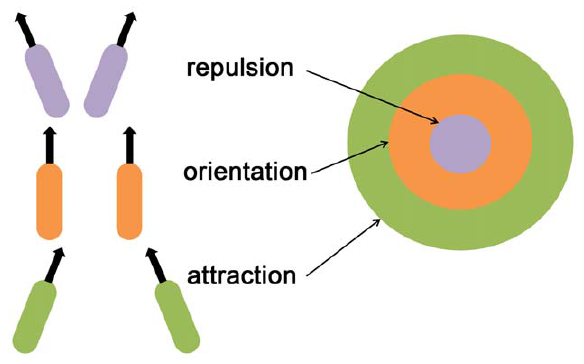
Figure 3. Illustration of agent-agent interactions in the swarm model. Agents repel from close agents, align with intermediate agents, and move towards far agents.